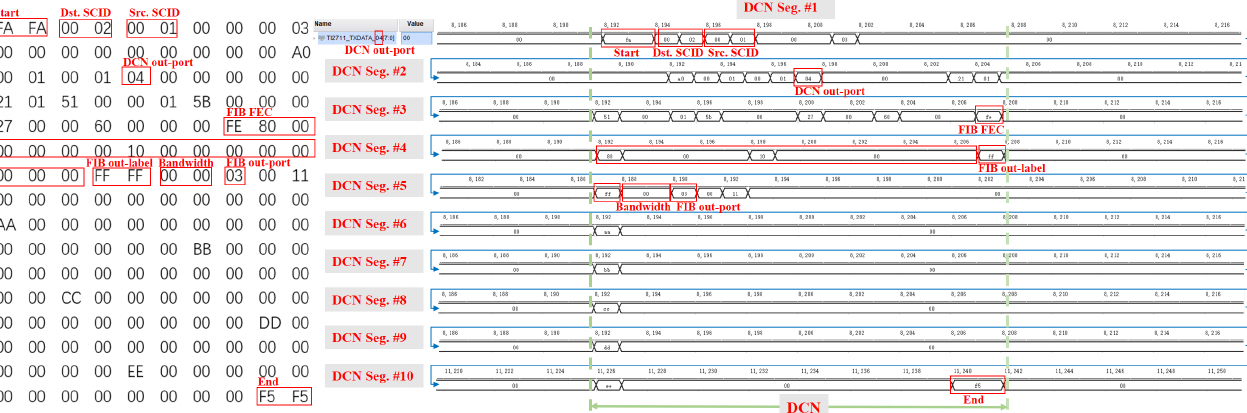
Figure 16. The configuration from the network management system to the remote node uses the data communication network overhead in the AOS frame. ( a ) The configuration of static forwarding information base from the network management system (SNMP manager). ( b ) The managing and controlling message of static FIB transmitted by node vx_simulator_01 through southbound interface.